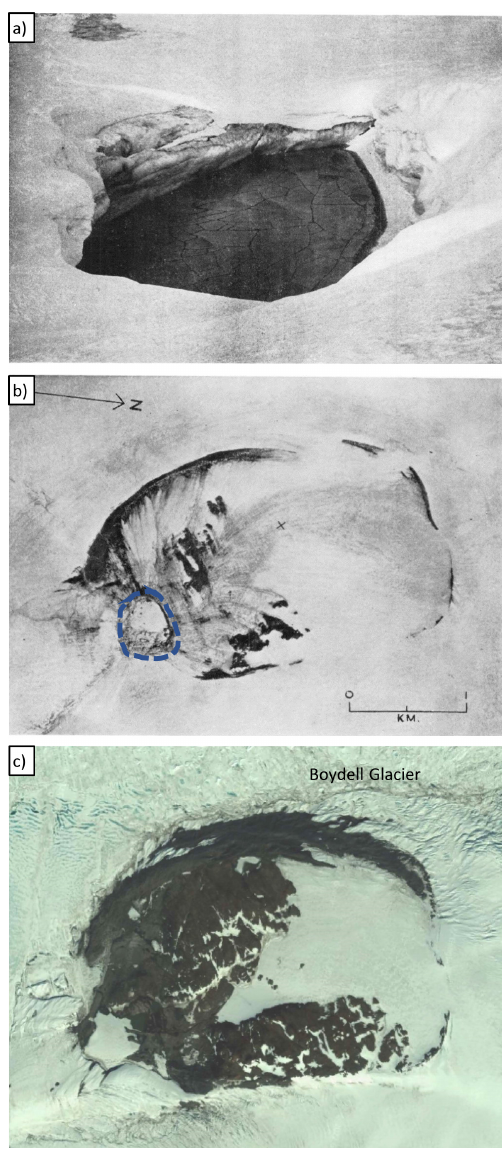
Figure 9. Analogous ice collapse structures on the northeastern Antarctic Peninsula. (a) The “ice caldera” at Nobby Nunatak, Hope Bay, in July 1958 (Koerner, 1964). This was approximately 30–50m in diameter with 20m high ice cliffs and partially filled with water when the photograph was taken. The feature had disappeared by 1960. (b) The ice caldera (marked by dotted blue line) 2.8km west of Mount Wild near Sjögren and Boydell glaciers in February 1957 (Aitkenhead, 1963). This feature was a 380m diameter feature with 20m ice cliffs. (c) The same feature in 2015 (shortly before the re- treat of the Boydell Glacier). With the loss of Prince Gustav Chan- nel Ice Shelf between 1989 and 1995 (Cooper, 1997) the bounding glaciers have retreated, and the feature is now part of an extensively deglaciated nunatak adjacent to the coast of Sjögren Inlet. © Google Earth Imagery date 1 January 2015, Maxar Technologies.